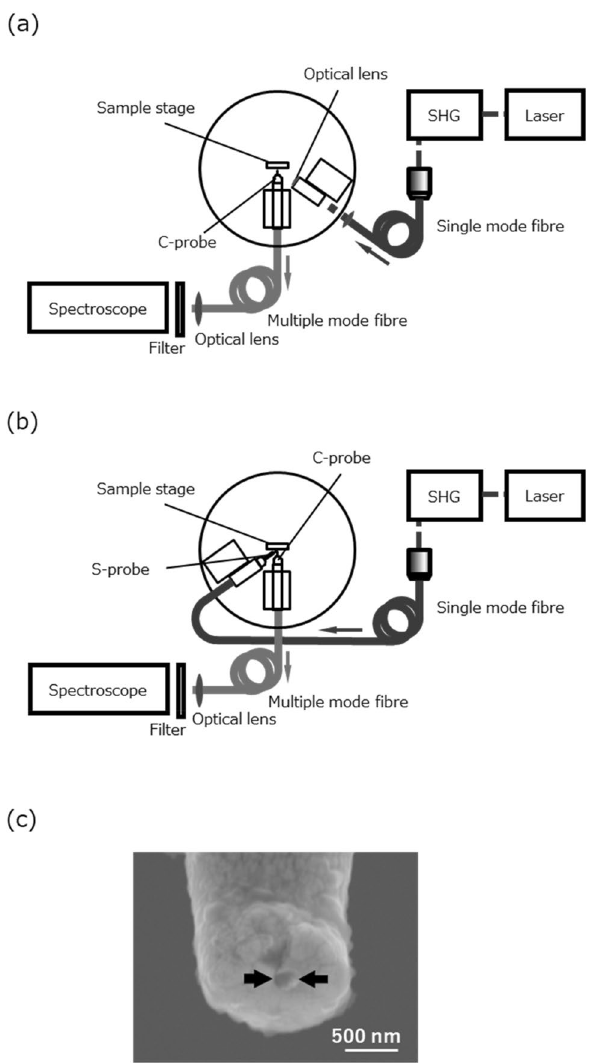
Figure 3. ( a ) Schematic image of the C-mode operation setup. The excitation was conducted with an optical lens on the side attachment. ( b ) Schematic image of the two-probe measurement setup. The excitation was conducted with S-probe. ( c ) A scanning electron microscope image of a typical aperture of